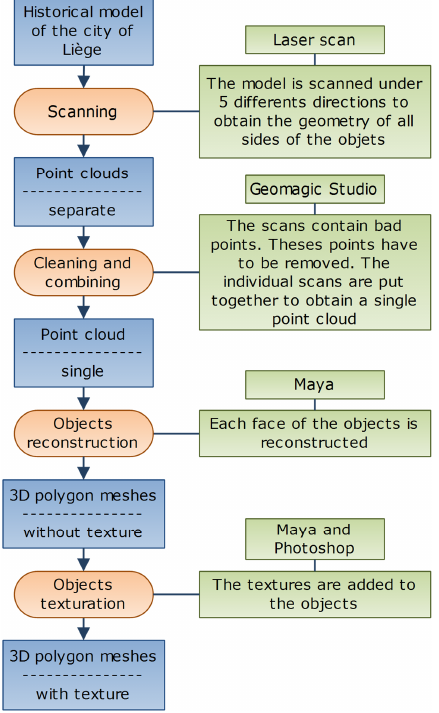
Figure 3. 3D data acquisition and object